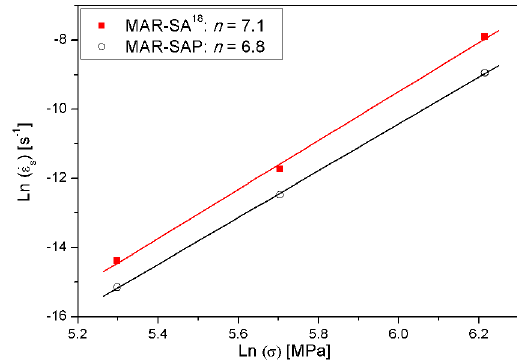
Figure 6: Dependence of steady-state rate on applied stress at 650 ºC for MAR-SA 18 and MAR-SAP (the slope is n ).